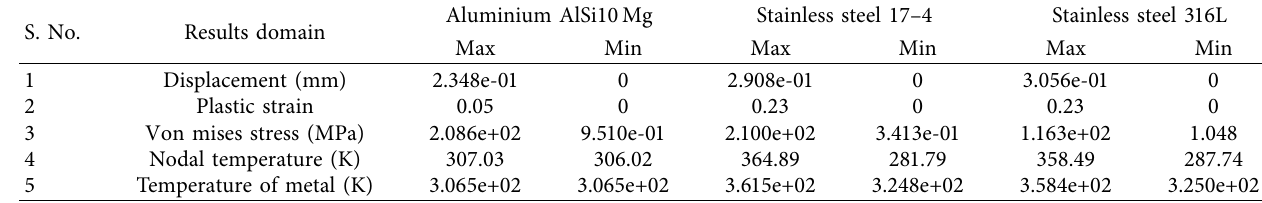
Table 7: Simulation results For the Rank 1 position.